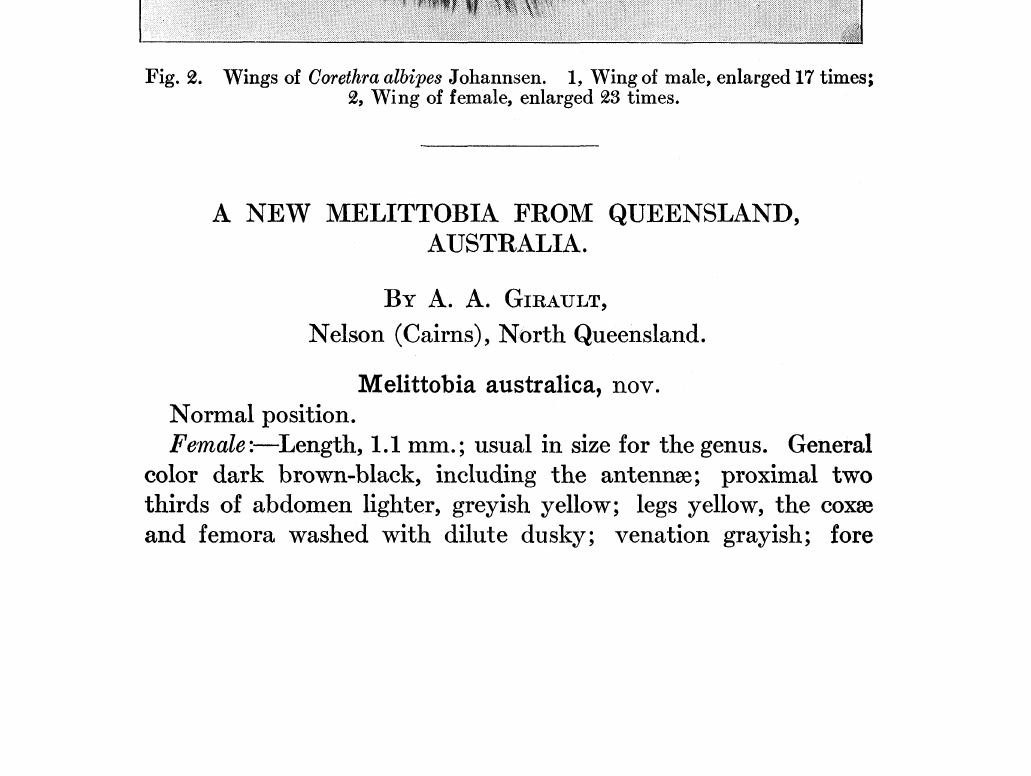
. Wings of Corethra albipes Johannsen. 1, Wing of male, enlarged 17 times; $, Wing of female, enlarged 3